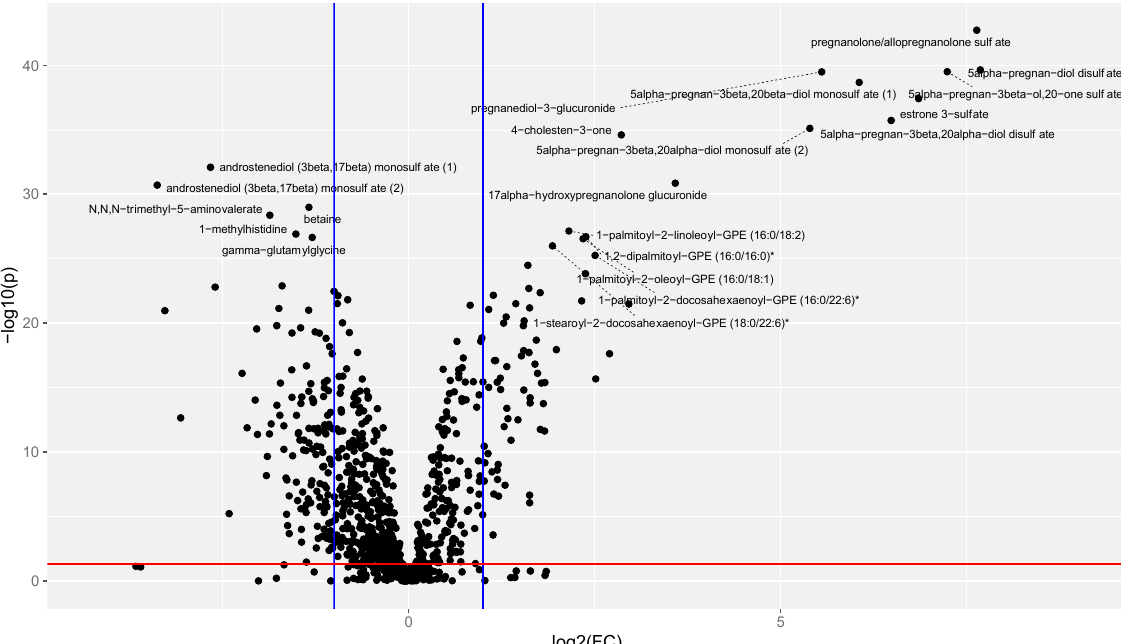
(2)androstenediol (3beta,17beta) monosulfate (1) androstenediol (3beta,17beta) monosulfate N,N,N−trimethyl−5−aminovalerate gamma−glutamylglycinebetaine 1−methylhistidine